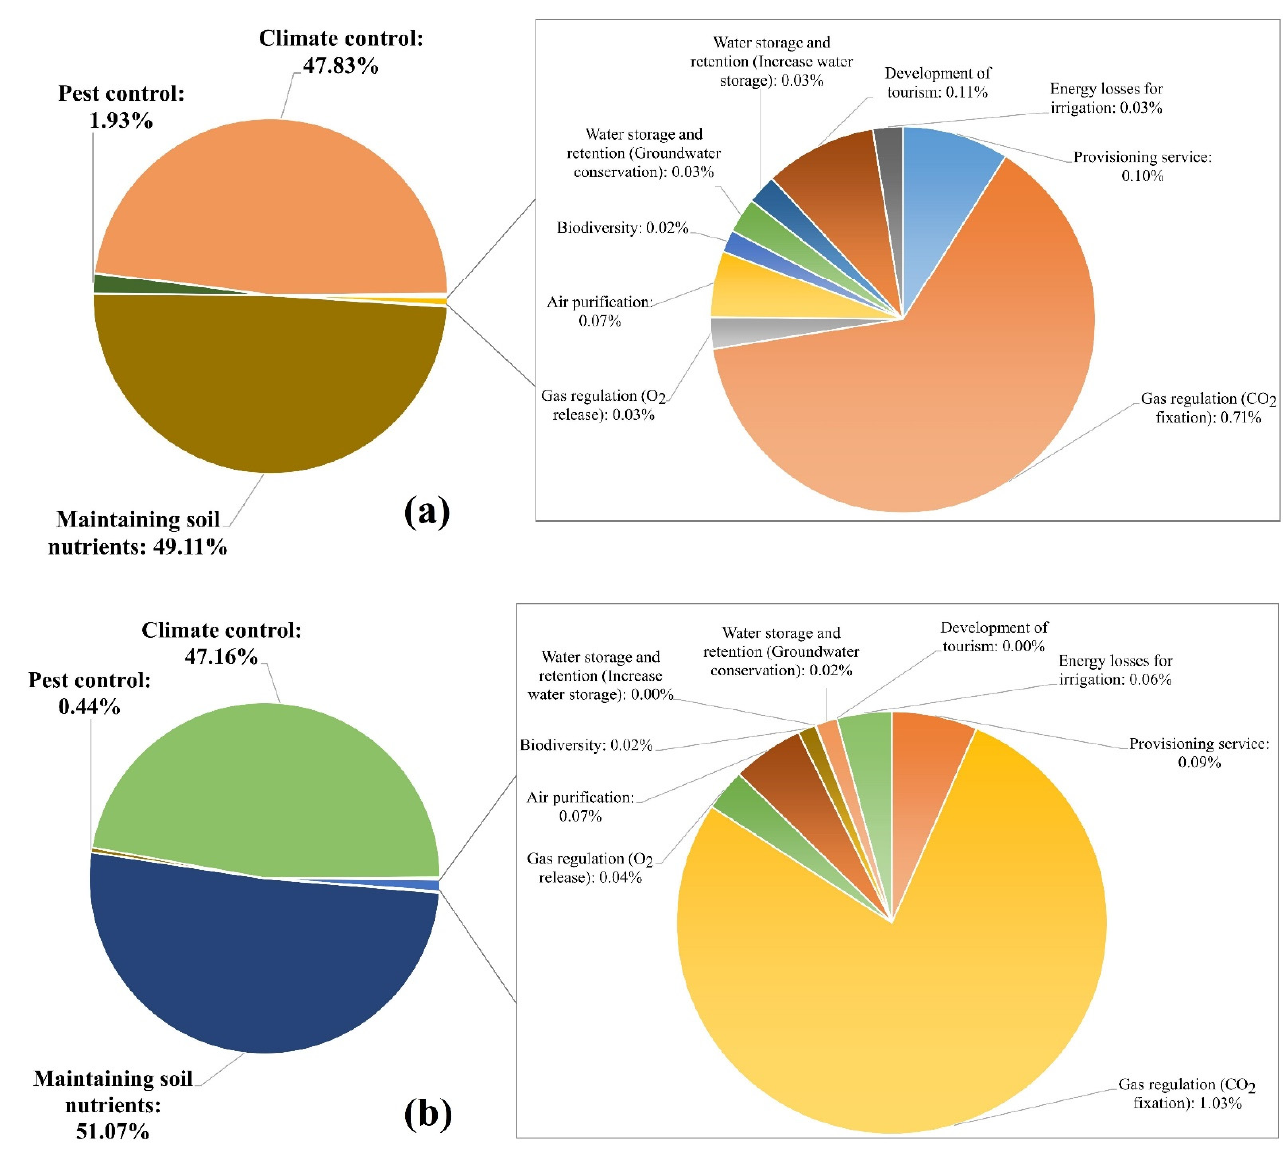
Figure 2. Proportion of service types: ( a ) rice–fish co-culture system, ( b ) rice monoculture system.